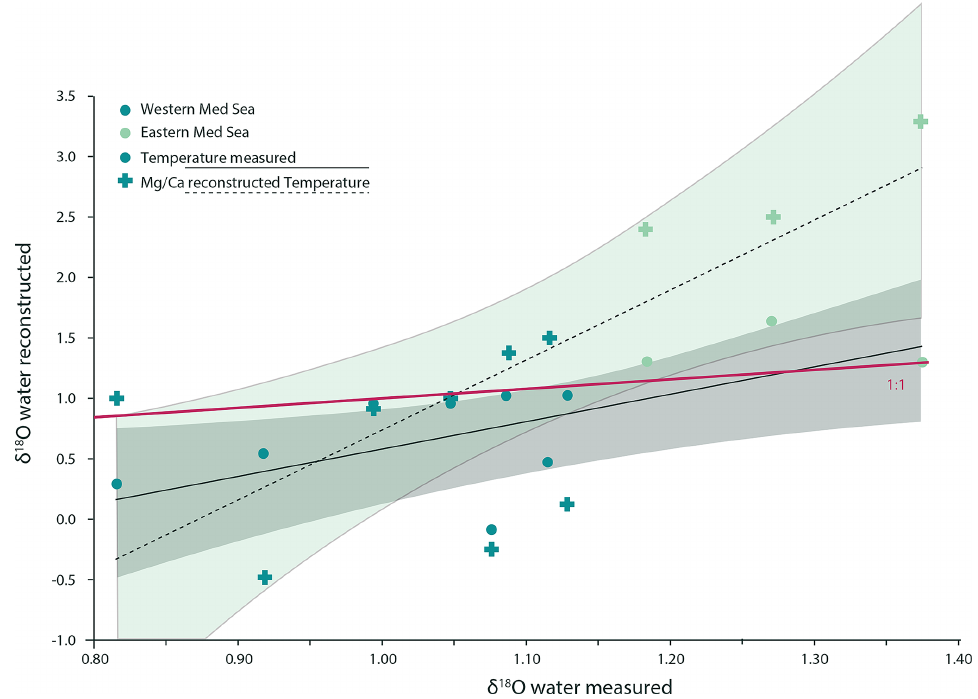
Figure 8. The relationship between δ 18 O seawater measured in the Mediterranean Sea and δ 18 O seawater calculated from foraminiferal geochemistry ( G. ruber albus ). The relationship shown with dashed lines and cross-shaped markers represents values calculated using foraminiferal δ 18 O as well as Mg / Ca as an additional temperature proxy to decouple the effect of temperature and salinity on δ 18 O. The relationship shown with the continuous lines and circular markers shows the same samples; however, instead of using temperature val- ues derived from foraminiferal Mg / Ca ratios, in situ measurements for temperature were used, and the relationship can be described as δ 18 O water_reconstructed = 2 . 62( ± 0 . 69) × δ 18 O water_measured − 63 . 99( ± 26 . 11) with an adjusted R 2 of 0.37. The temperature gradient was 2.2 ◦